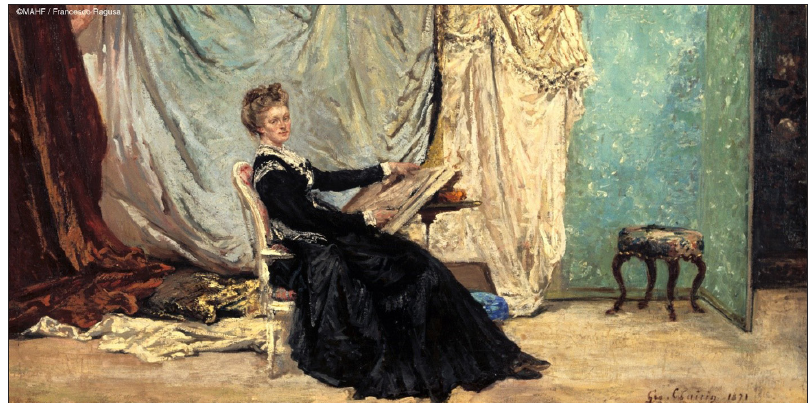
Fig. 9 : Georges Clairin, Marcello dans son atelier , 1871, oil on canvas, Musée d’art et d’histoire Fribourg (MAHF). ©